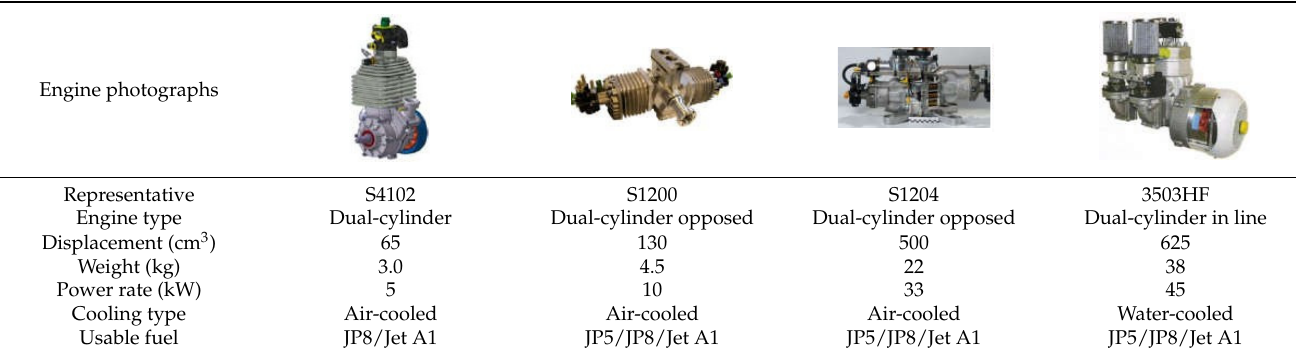
Table 2. Heavy-oil, two-stroke, direct-injection, spark-ignition, piston engine produced by the Hirth Company, Germany.